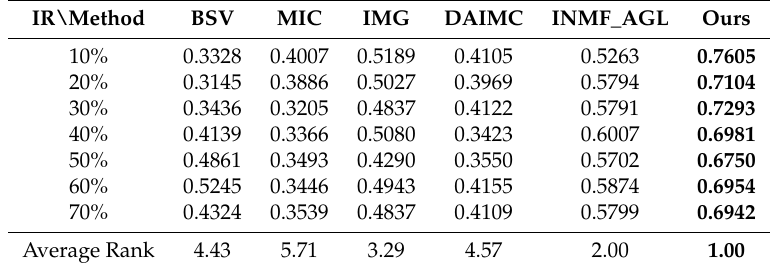
Table 2. ACCs and average ranks on Caltech7 under different incomplete ratios. Bold numbers denote the best result.